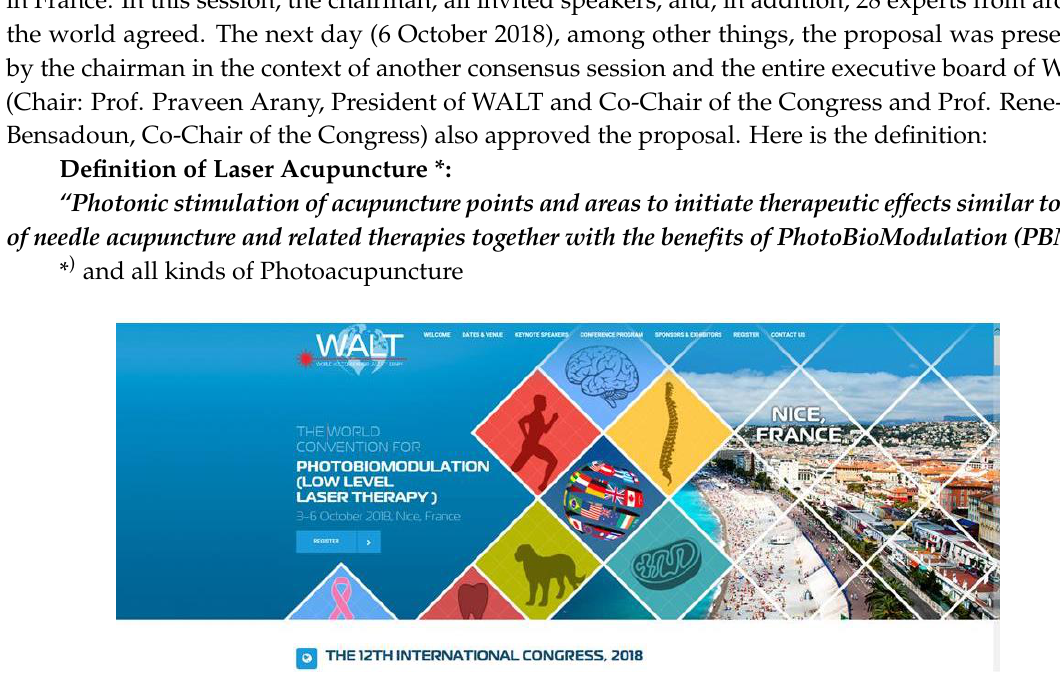
Figure 1. W orld A ssociation for photobiomodu L ation T herapy (W.A.L.T.). 12th International Congress, Nice, France, 3–6 October 2018 (© WALT).